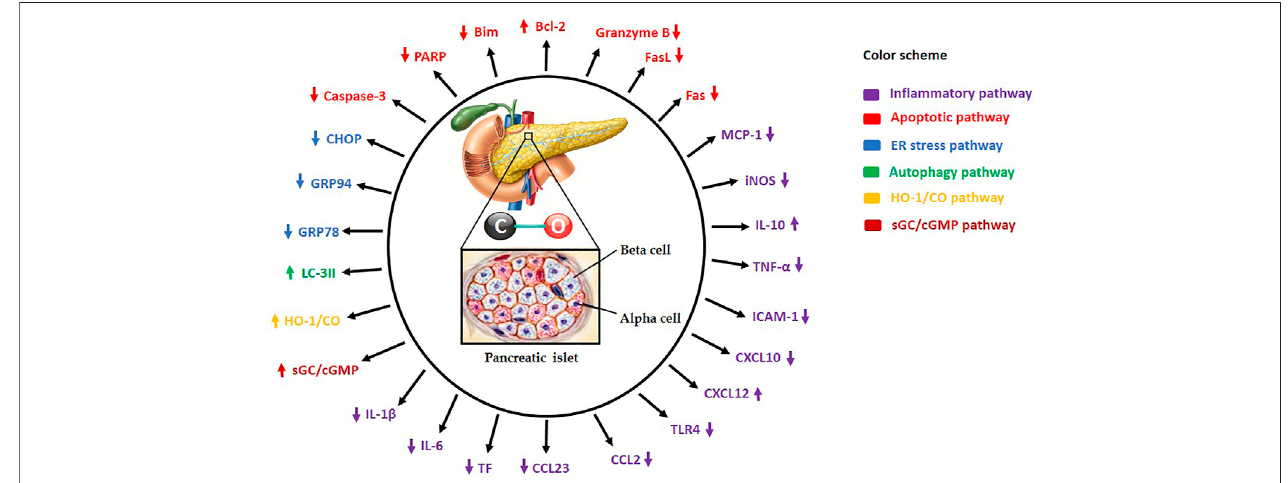
FIGURE 1 | Carbon monoxide (CO) administration to islet donor and/or recipient or supplementation of standard preservation medium with CO protects and increases islet yields by modulating several molecular mechanisms. HO-1/CO: Heme oxygenase-1/carbon monoxide, sGC/cGMP: Soluble guanylate cyclase/cyclic guanosinemonophosphate,TNF- α :Tumornecrosisfactor-alpha,iNOS:Induciblenitricoxidesynthase,IL-1 β :Interleukin-1beta,IL-6:Interleukin-6,IL-10:Interleukin-10, ICAM-1: Intercellular adhesion molecule-1, Bcl-2: B-cell lymphoma-2, Caspase-3: Cysteine-aspartic proteases-3, TLR4: Toll-like receptor-4, ATP: Adenosine triphosphate,PARP:Poly-ADPribosepolymerase,MCP-1:Monocytechemoattractantprotein1,FasL:Fasligand,Bim:Bcl-2interactingmediatorofcelldeath,GRP78: Glucose-regulated protein 78, GRP94: Glucose-regulated protein 94, CHOP: C/EBP homologous protein, LC-3II: Microtubule-associated proteins 1A/1B-light chain 3B, CCL2: Chemokine (C-C motif) ligand 2, CCL23: Chemokine (C-C motif) ligand 23, CXCL10: C-X-C motif chemokine 10, CXCL12: C-X-C motif chemokine 12, and TF: Tissue